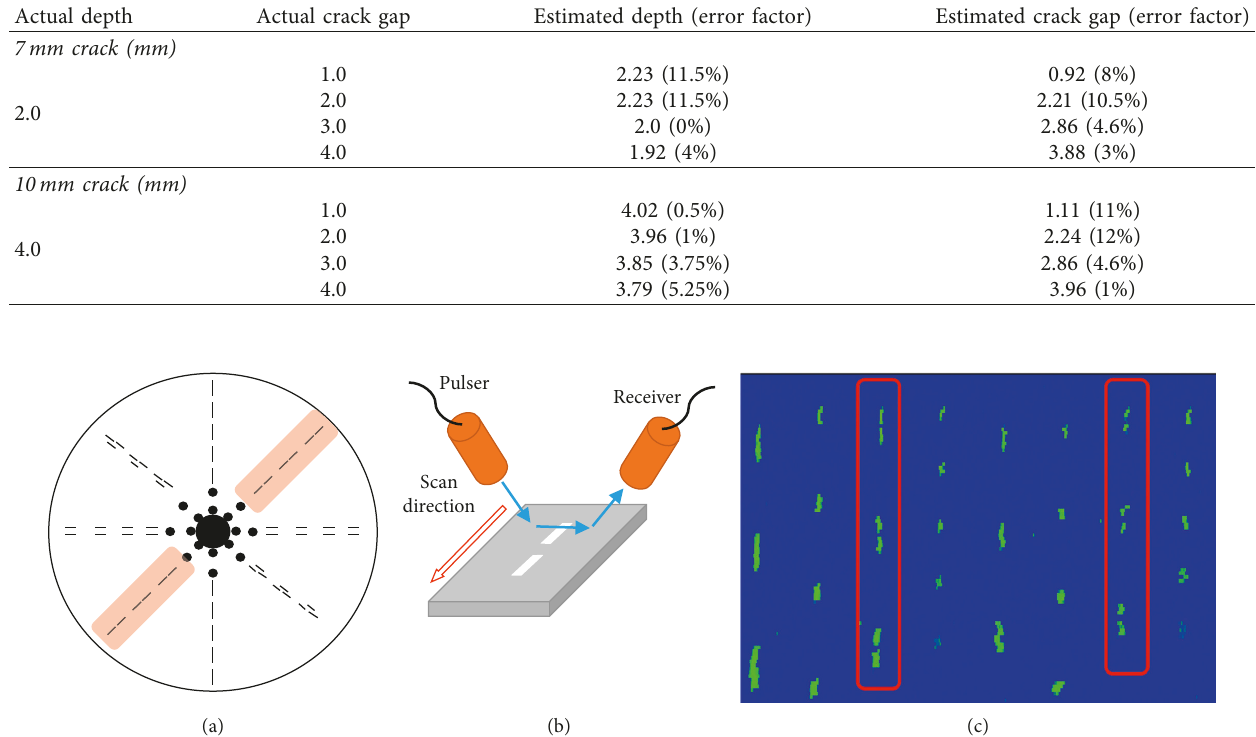
Figure 17: Inspection results for 10mm H-double type crack: C-scan (left) and cross section amplitude (right). Table 3: Inspection results for H-double type crack (mm).